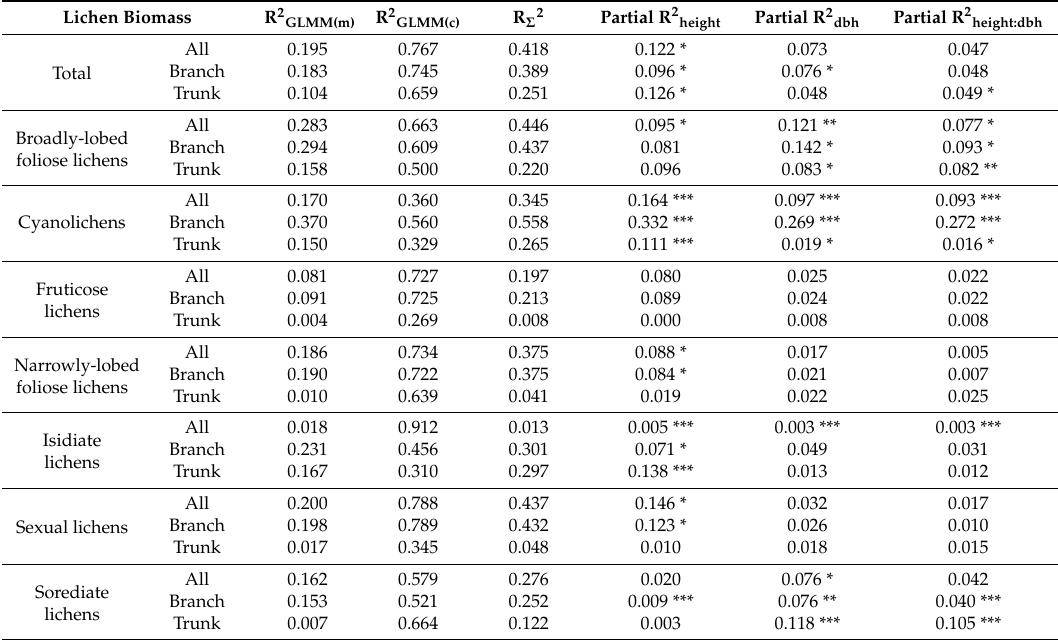
Table 3. The results of generalized linear mixed models testing the influence of tree dbh and height on epiphytic lichen biomass per tree in five forest types in the Ailao Mountains, Southwest China. R 2 GLMM(m) : marginal coefficient, describes the variance in the fixed effects; R 2 GLMM(c) : conditional coefficient, describes the variance in both the fixed and random effects; R Σ 2 : the proportion of generalized variance explained by the fixed predictors; Partial R 2 height : the proportion of generalized variance explained by the tree height; Partial R 2 dbh : the proportion of generalized variance explained by the tree dbh; Partial R 2 height:dbh : the proportion of generalized variance explained by the interaction between tree height and dbh. p < 0.05 *; p < 0.01 **; p < 0.001 ***. Lichen Biomass R 2 GLMM(m) R 2 GLMM(c) Partial R 2 dbh Partial R 2 height:dbh